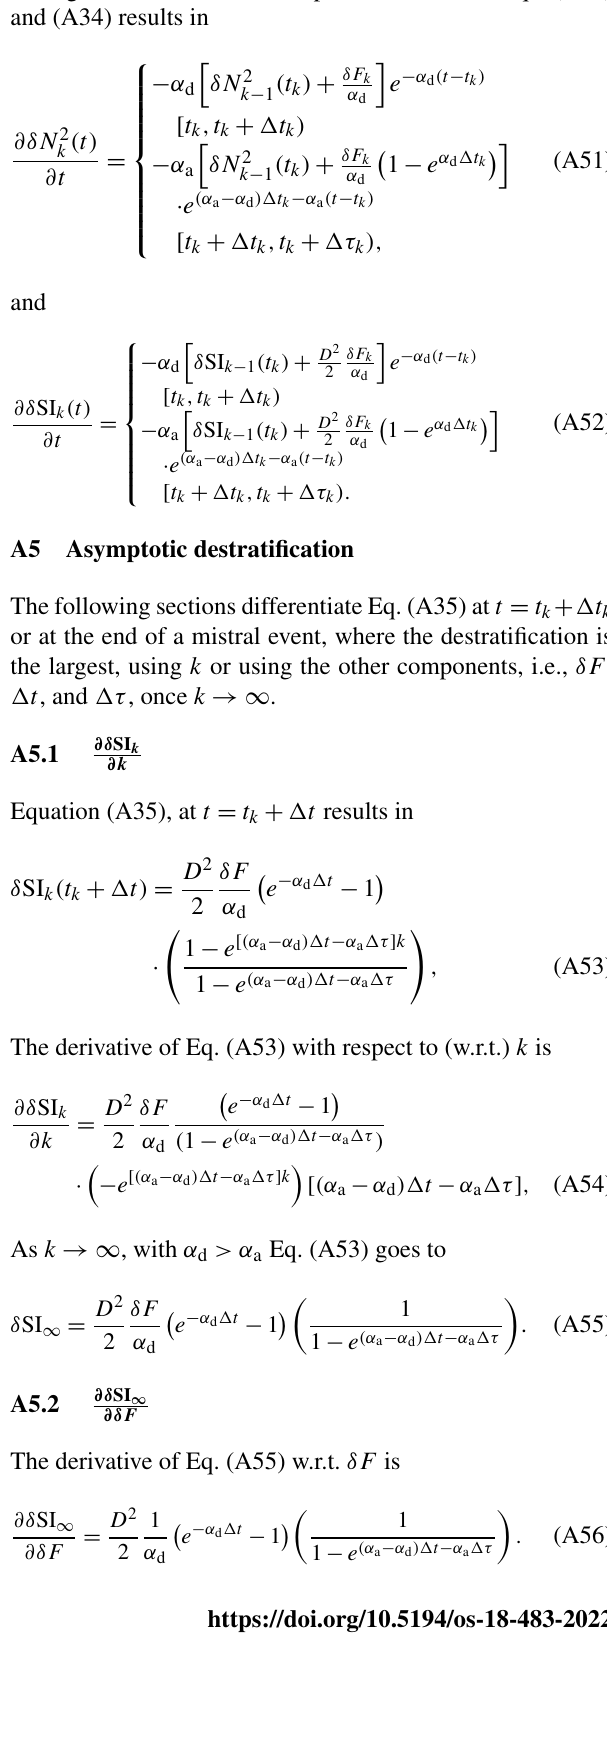
Table A1. The mistral strengths, δF k , for each of the precondition- ing phase events, using α d and α a from Sect. A2 and the rest of the preconditioning period mistral characteristics from Table 1 plugged into Eq.